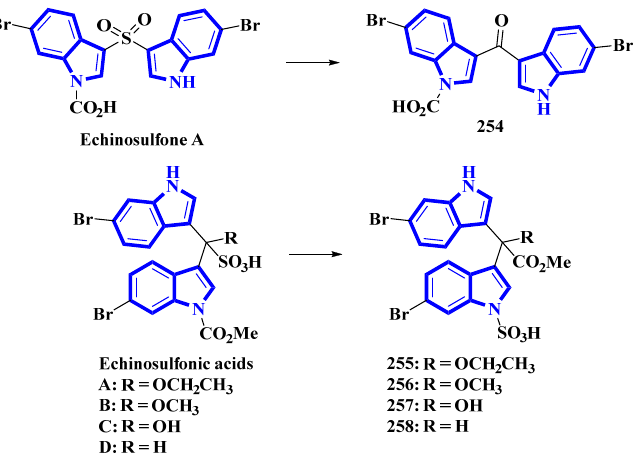
Figure 13. Reappraised structures of echinosulfone A and echinosulfonic acids (A–D) 254–258 .